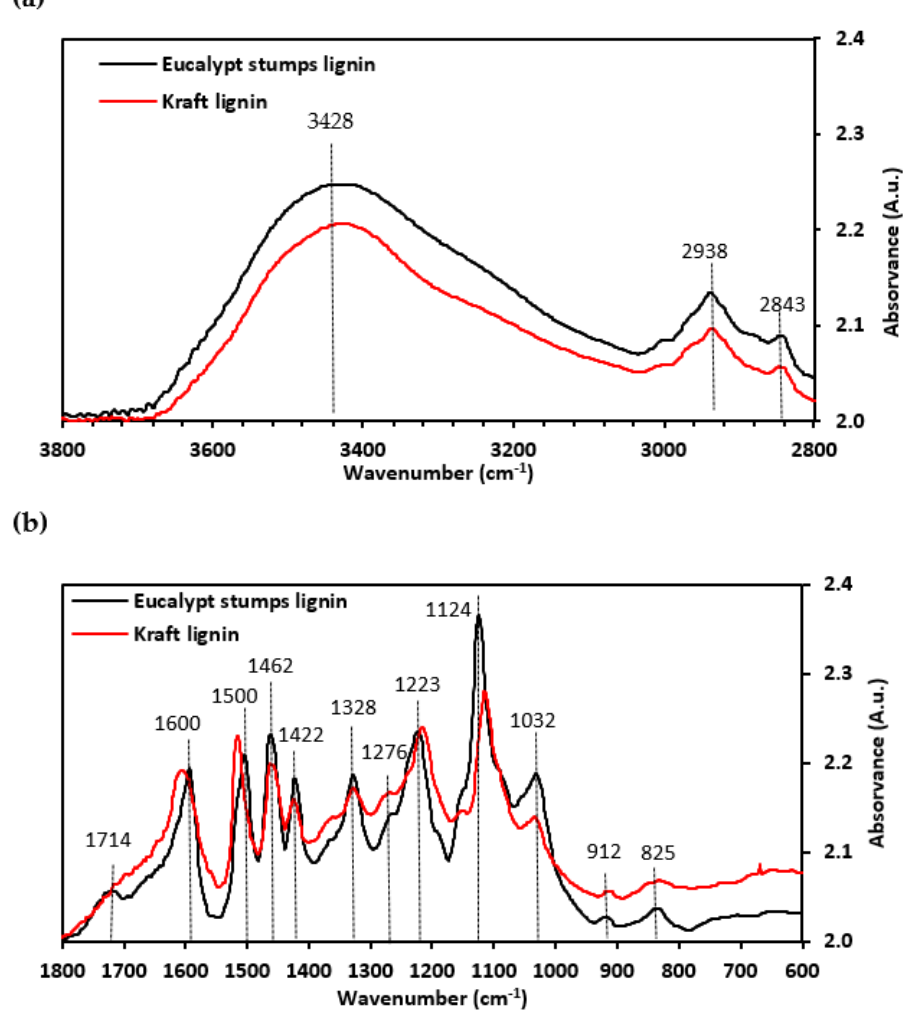
Figure 3. FTIR spectra of the eucalypt stump lignin and kraft lignin are depicted in the region 3800–2800 cm − 1 ( a ) and in the region 1800-600 cm − 1 ( b ). Measurements in absorbance units (A.u.).